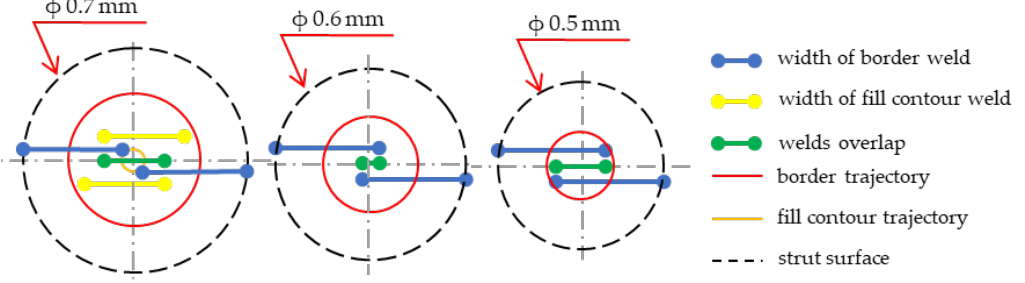
Figure 16. SLM Solutions universal struts laser strategy.